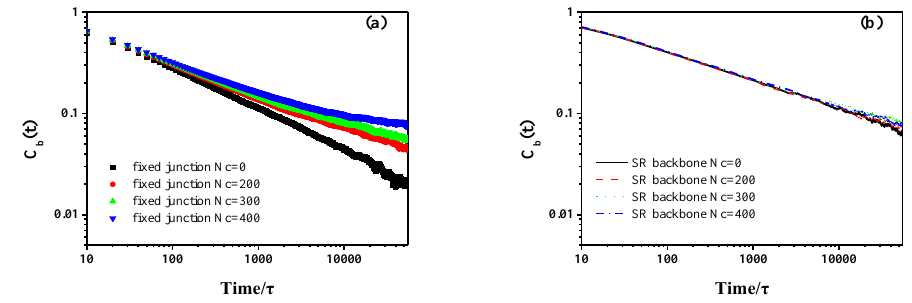
Figure 3. The bond autocorrelation function of ( a ) backbone in fixed junction systems and ( b ) backbone in SR systems.